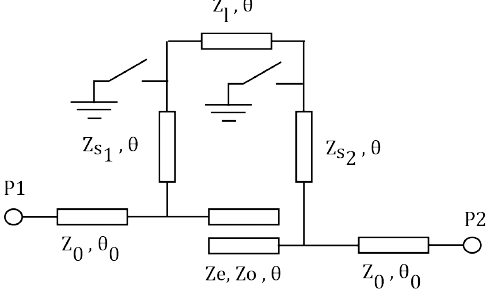
Figure 1. Ideal reconfigurable filter.